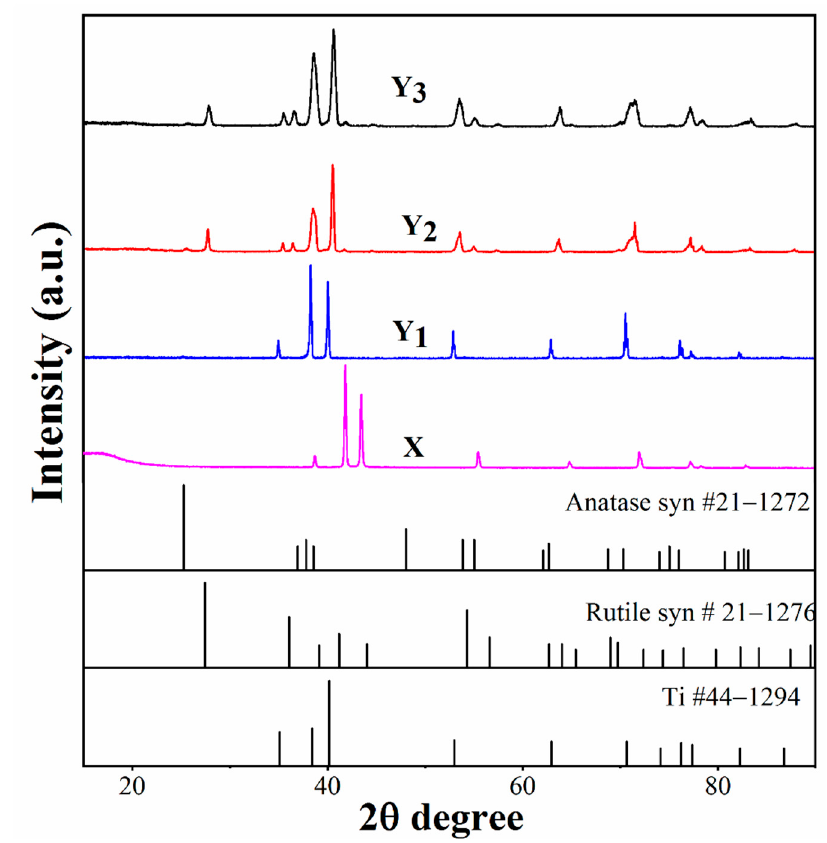
Figure 3. XRD spectra of prepared groups X, Y 1 , Y 2 and Y 3 .